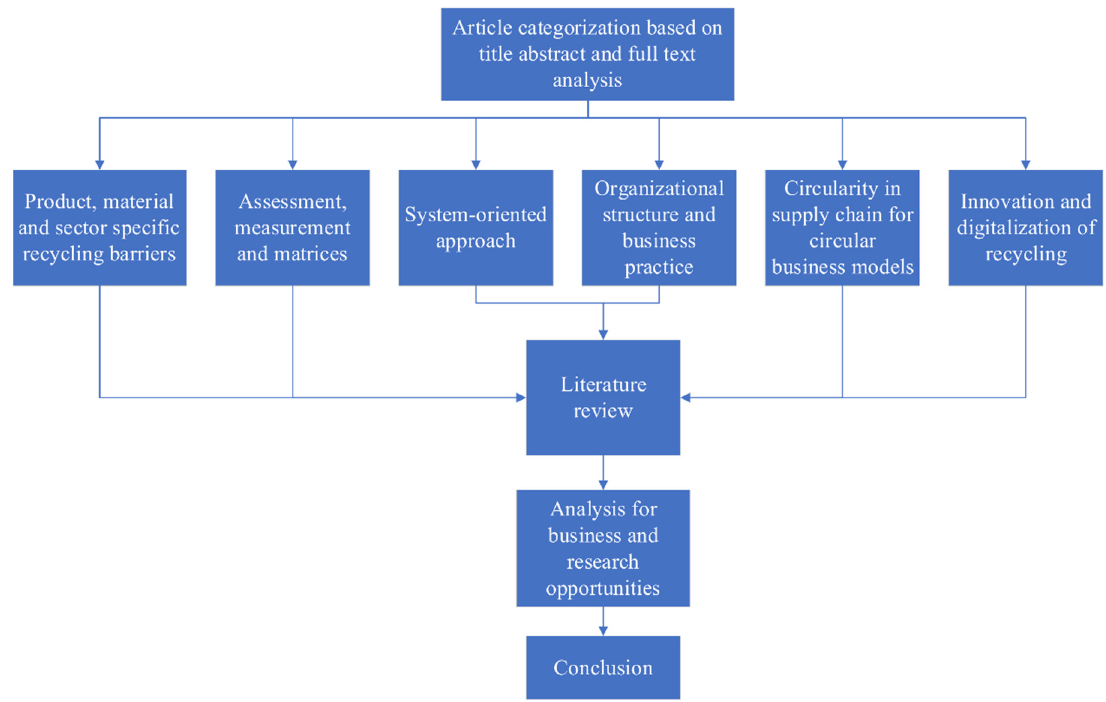
Figure 4. Research framework of the study.